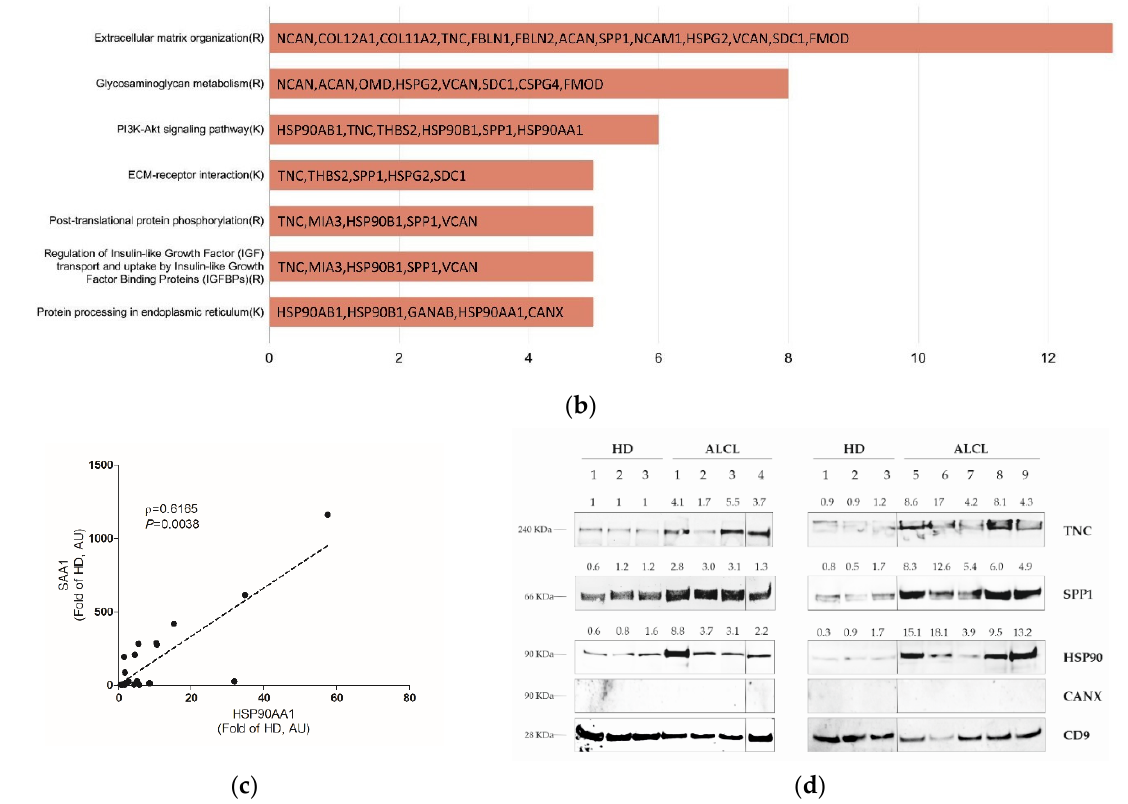
Figure 4. Pathway modules involving proteins overrepresented in S-EVs of ALCL patients highlight phosphatidylinositol 3-kinase (PI3K)/AKT signaling pathway proteins in the plasma S-EVs cargo in ALCL. ( a ) Pathway-derived network and ( b ) Reactome and Kyoto Encyclopedia of Genes and Genomes (KEGG) modules significantly enriched (FDR < 0.01) by the proteins overrepresented in ALCL S-EVs. In the network, node size indicates the protein abundance (arbitrary units ×1000) in ALCL; color shades indicate the log 2 fold change (LFC) of protein abundance with respect to healthy donors (HD). Only the overexpressed proteins with average abundance ≥ 5000 in ALCL are shown. Small grey nodes represent first neighbors connecting two or more of the proteins overrepresented in ALCL S-EVs. Edges indicate different types of experiments from which the relationship was determined: expression regulation (arrow), complex (solid line) or predicted (dashed line). ( c ) Scatterplot showing the Spearman correlation between heat shock protein 90 isoform alpha 1 (HSP90AA1) and serum amyloid A1 (SAA1) in 20 ALCL-derived S-EVs ( ρ = 0.6165, p = 0.0038). Data in arbitrary units (AU) are expressed as fold of HD. ( d ) Western blotting of tenascin C (TNC), osteopontin (SPP1) and HSP90 in ALCL and HD samples. Band densities were acquired using ImageJ software and expressed as a fold of HD bands’ mean density. CD9 was used as a loading control. Vertical lines were inserted to indicate repositioned gel lanes. Expression levels between ALCLs and HDs were compared by using the Mann–Whitney test.